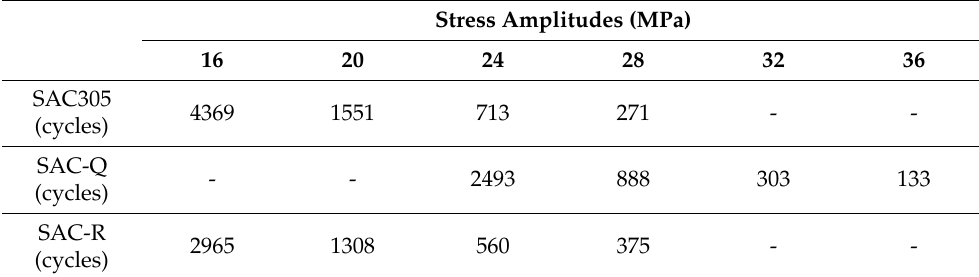
Table 4. Characteristic life (cycles) of non-aged individual solder joints.